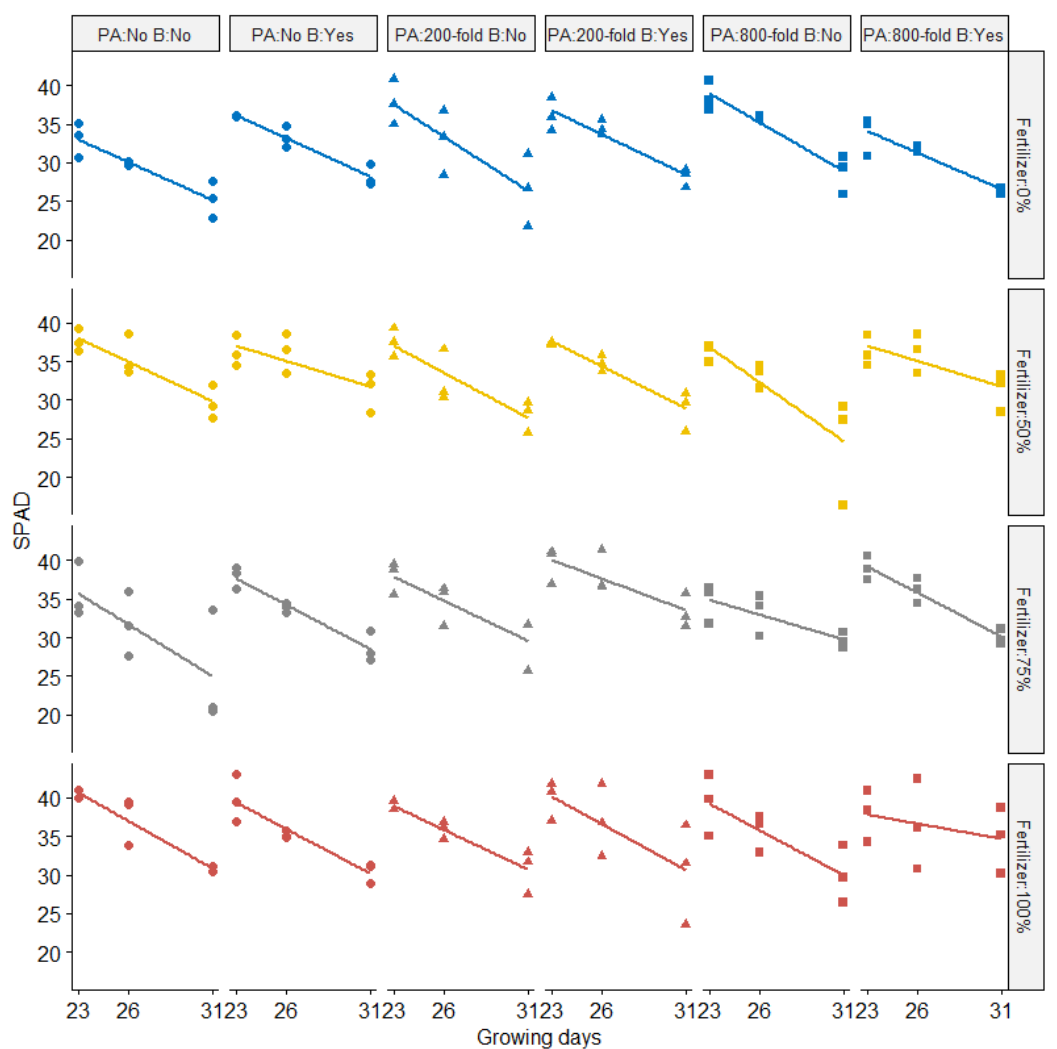
Figure 3. SPAD values from Komatsuna plants over three growing days, with fold dilution treatments of pyroligneous acid (PA), biochar (B), and chemical fertilizer rates of 0%, 50%, 75%, or 100%. Symbols represent the amount of pyroligneous acid (Circle: No application; Triangle: pyroligneous acid with 200-folddilution; Square: pyroligneous acid with 800-fold dilution while different colors represent the rates of chemical fertilizer (Blue: Fertilizer 0%; Yellow: Fertilizer 50%; Gray: Fertilizer 75%; Red: Fertilizer 100%).